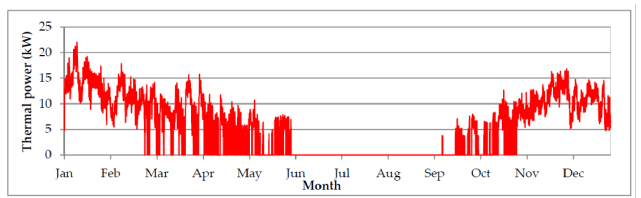
Figure 10. The hourly variation of the thermal power required by the Solar House.